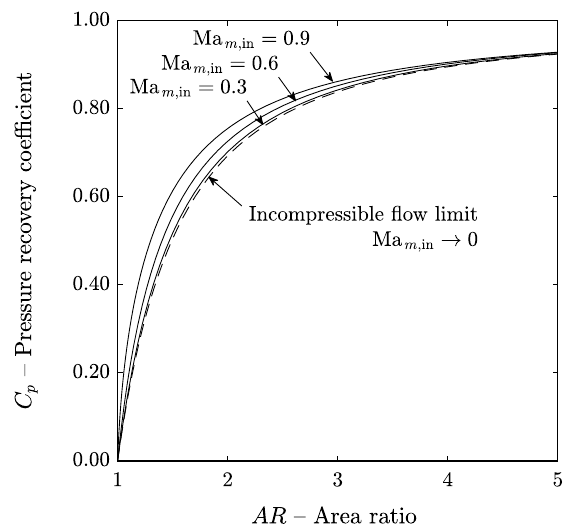
Figure 12. Influence of the inlet Mach